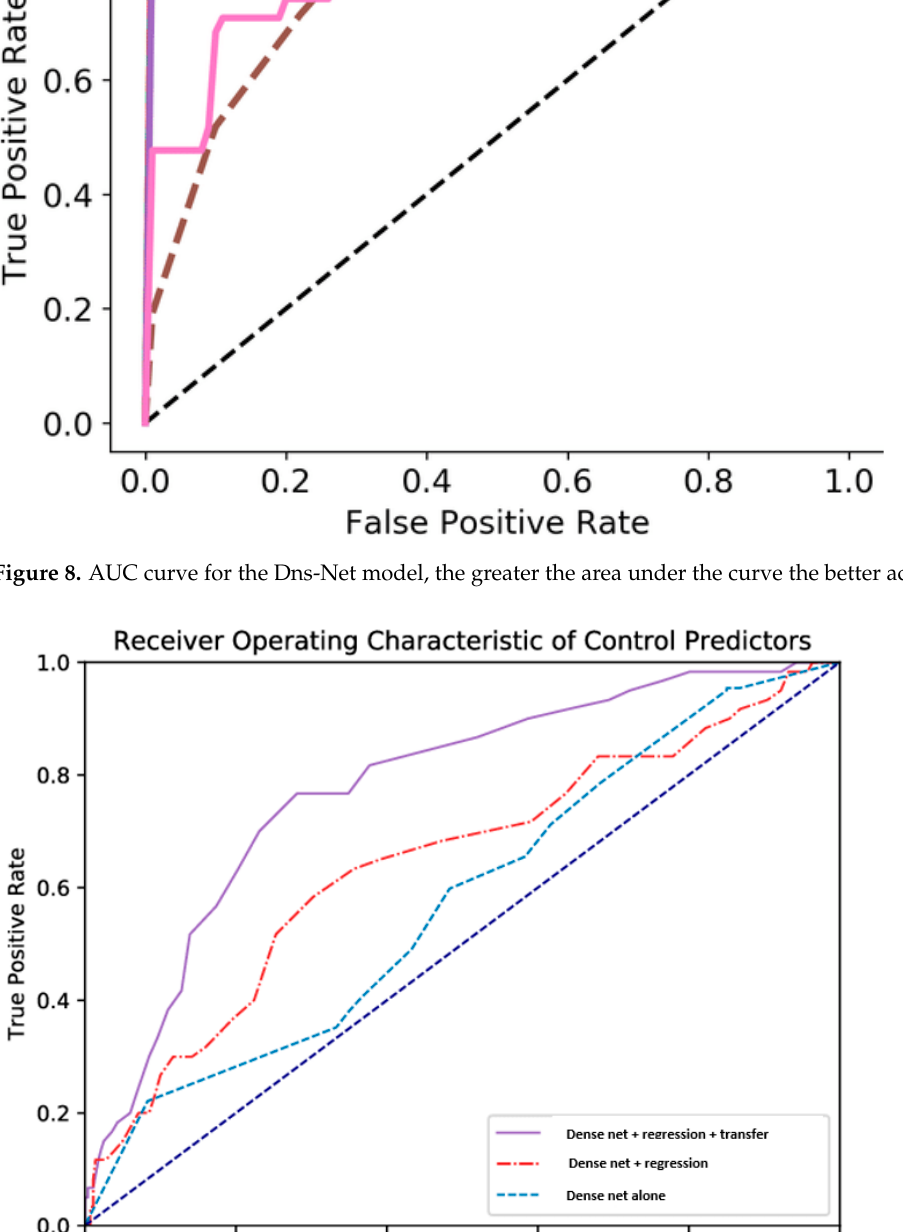
Figure 10. Precision versus recall of the Dns ‐ Net model with regression inferring the transfer learn ‐ ing effect, the precision increased with the transfer learning. The highest area under the ROC curve is 0.98 for the normal case (no ‐ defect struc ‐ tures). The lowest area of 0.90 for the pristine case of crystal structures. By employing the